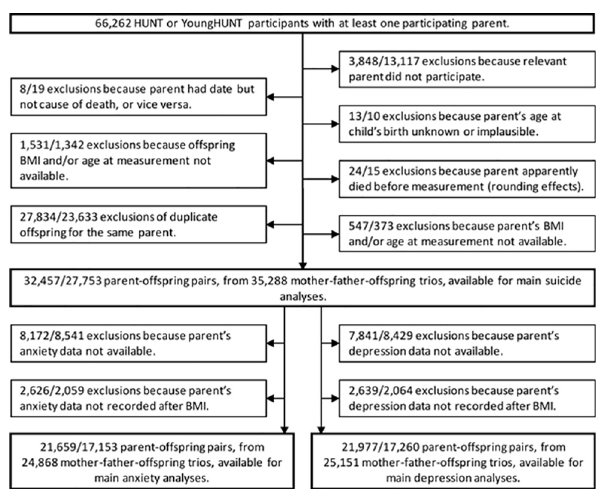
Fig 1. Flow of participants through the study. Numbers are listed as mother-offspring pairs / father- offspring pairs.